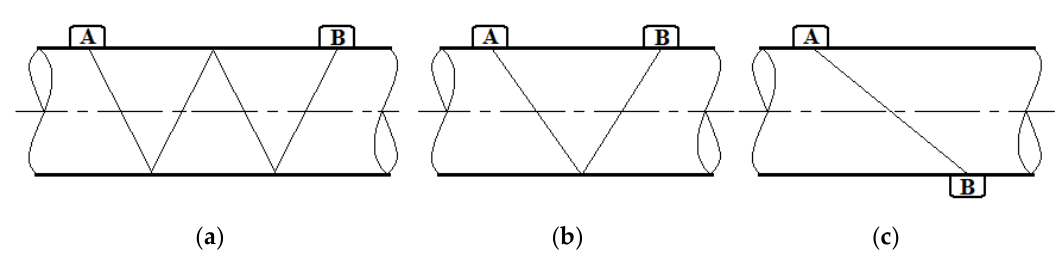
Figure 1. Arrangement of ultrasonic transducers. ( a ) W-type; ( b ) V-type; and ( c ) Z-type.